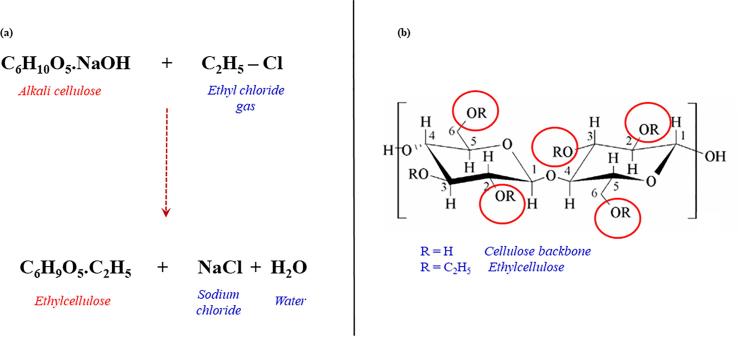
Illustrations of: (a) chemical synthesis of ethylcellulose (adapted from Rekhi and Jambhekar, 1995) and (b) chemical backbone structures of cellulose and ethylcellulose (adapted from Murtaza, 2012).